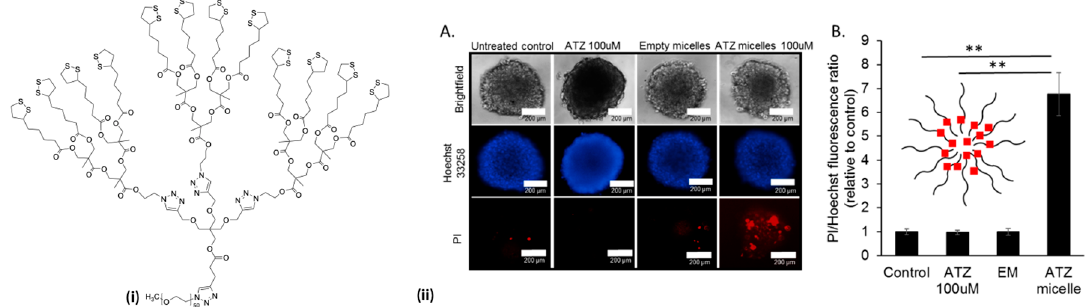
Figure 5. ( i ) Telodendrimer for combination therapy. ( ii ) Viability of glioblastoma spheroids treated with ATZ: ( A ) U251 spheroids treated with ATZ, empty telodendrimer micelles, and ATZ-loaded micelles; ( B ) Relative PI to Hoechst 33342 fluorescence intensity. ** indicates statistically significant differences. Reprinted with permission from [168]. Copyright 2017 American Chemical Society.